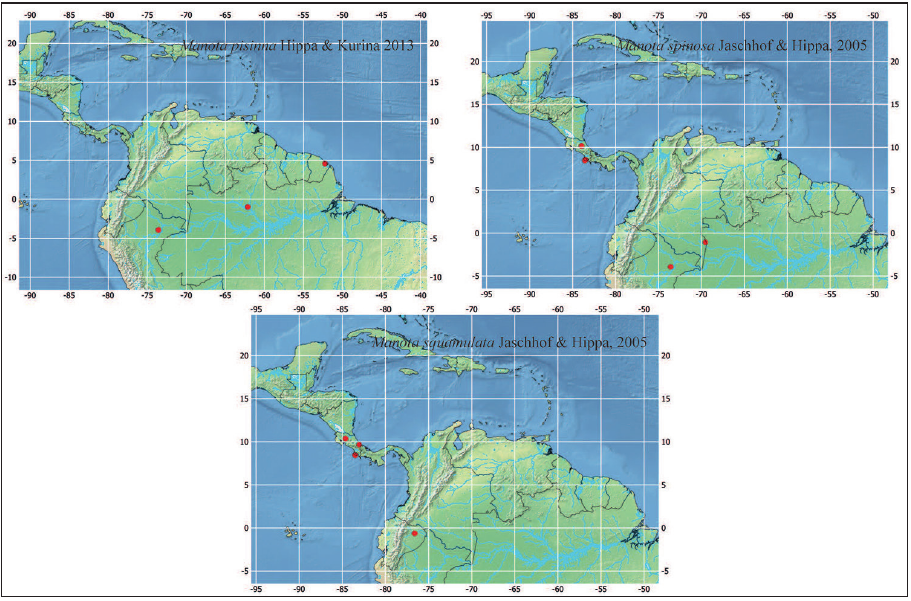
Figure 8. Distribution of described Manota species recorded in this